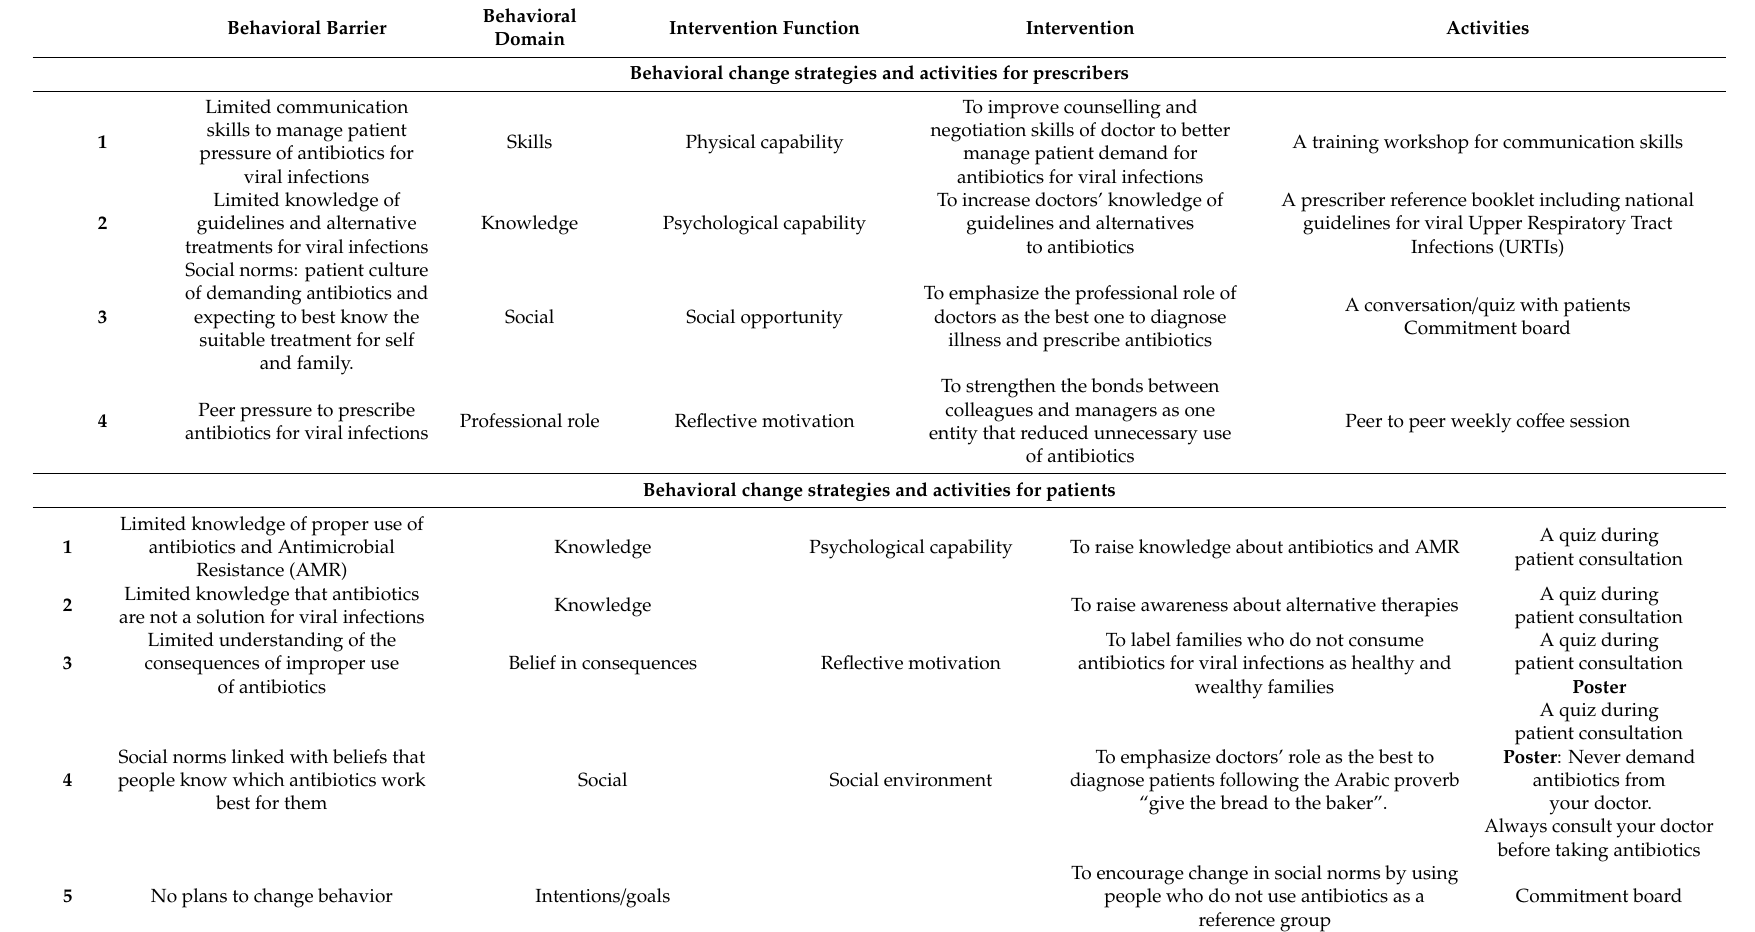
Table 4. Behavioral change strategies for prescribers or